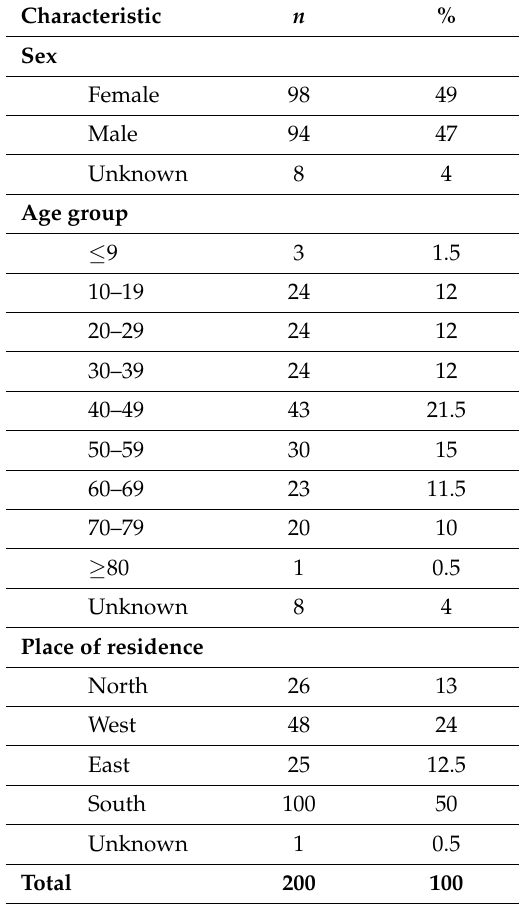
Table 2. Study population by demographic characteristics, Germany, 2000–2020 ( n =